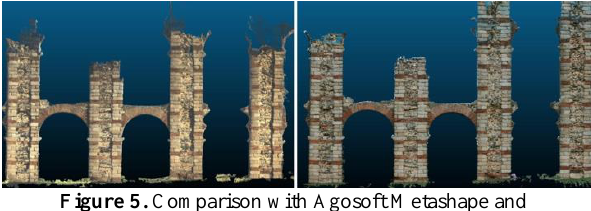
Figure 5. Comparison with Agosoft Metashape and Photorealistic model with the proposed system.